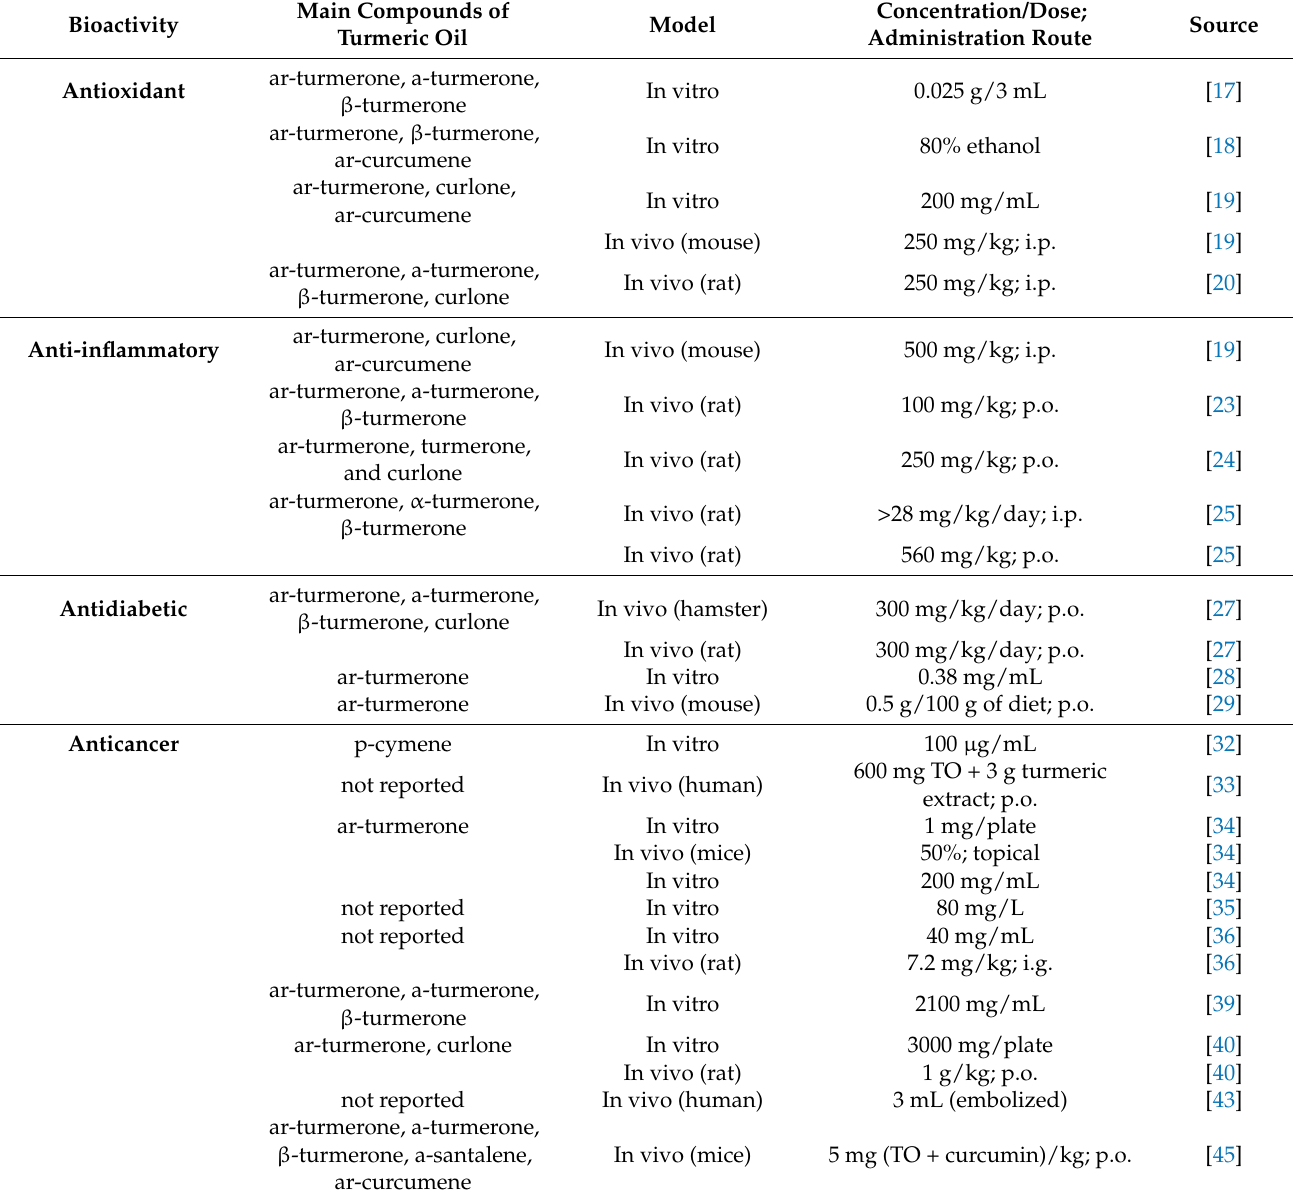
Table 1. A summary of studies focused on the bioactivities of turmeric